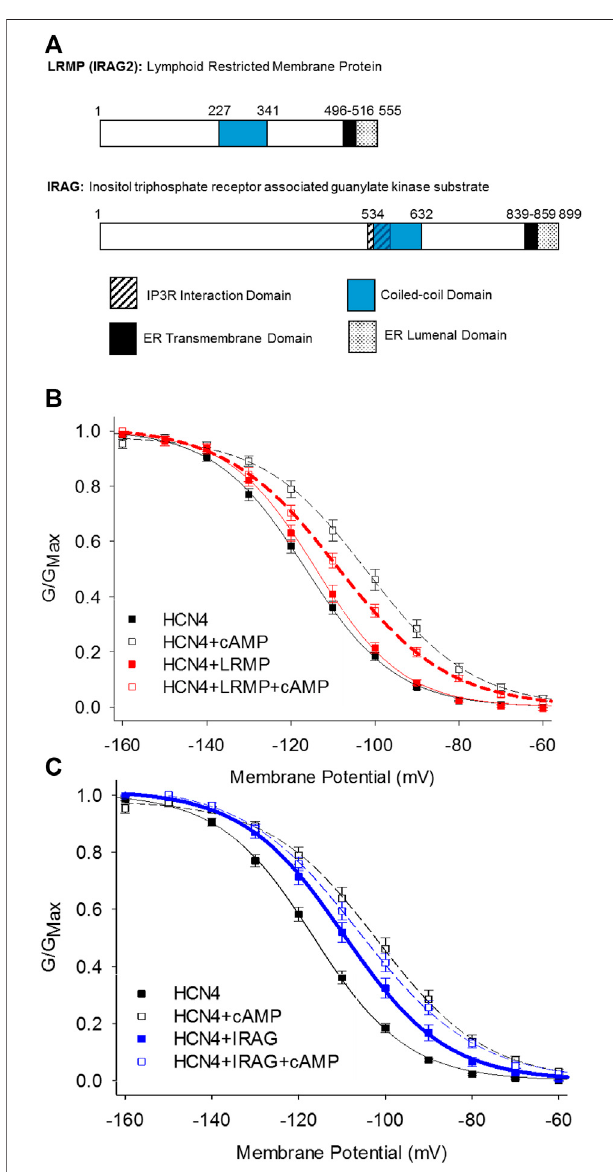
FIGURE 3 | LRMP and IRAG are isoform-speci fi c regulators of HCN4. (A) DomainstructureofLRMPandIRAG. (B) LRMPinhibitscAMP-dependent regulation of HCN4. (C) IRAG acts a cAMP mimetic that potentiates HCN4 in the absence of cAMP. From Peters et al., 2020a.